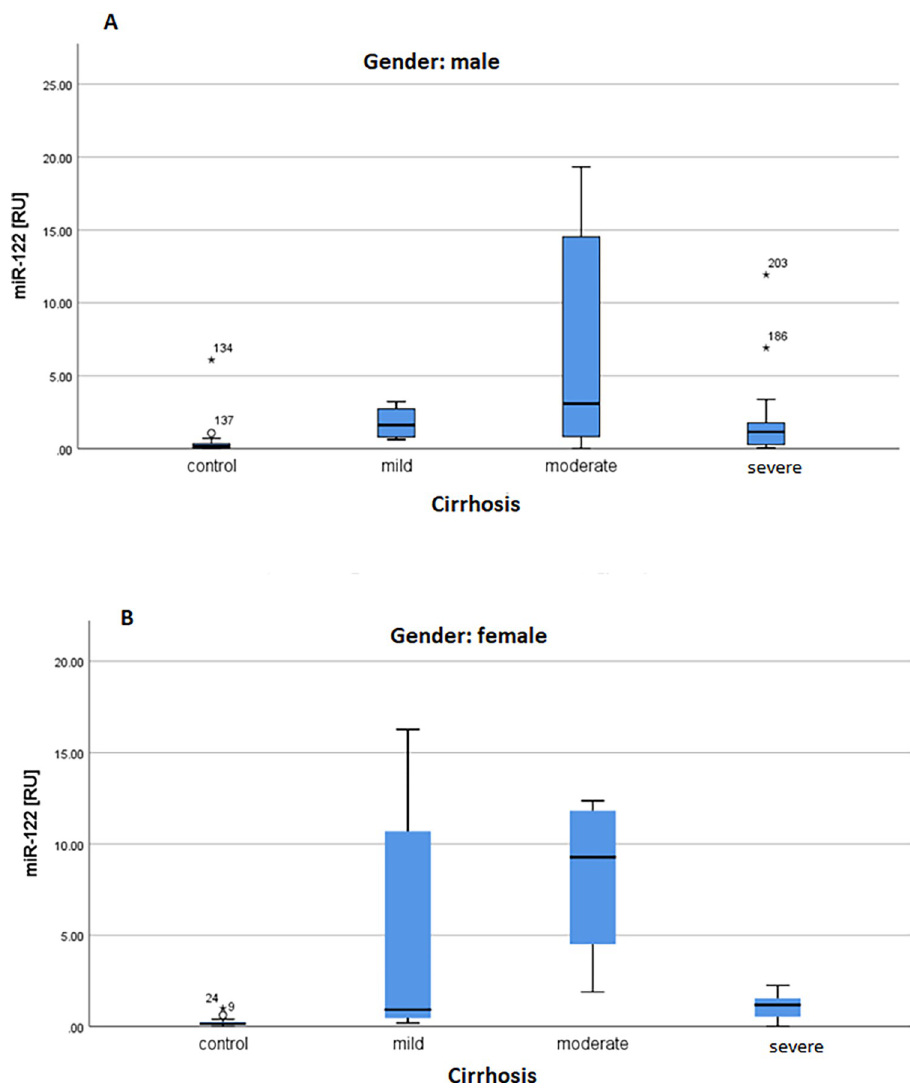
Fig 6. A, B: Boxplot of microRNA-122 steps: in cirrhotic patients.